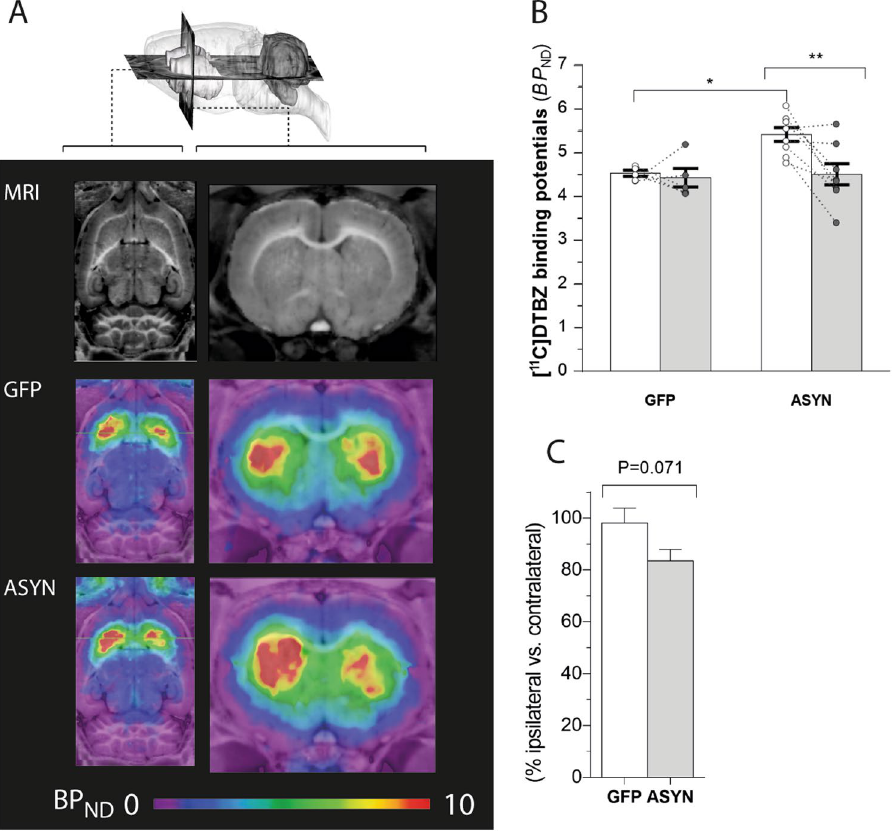
Figure 2. In vivo VMAT2 expression determined by [ 11 C]DTBZ PET. Representative axial ( A , left) and coronal ( A , right) sections of MRI atlas (top row) and parametric maps of in vivo [ 11 C]DTBZ binding potentials ( BP ND ) of GFP (middle row) and ASYN animals (bottom row) at 12 weeks post-surgery. While GFP animals showed similar binding in both sides of the striatum (middle row), a marked decrease in the binding in the ipsilateral side was observed in response to ASYN overexpression (bottom row). Quantification of [ 11 C]DTBZ binding potentials ( BP ND ) in each side of striatum were done using Logan plot with cerebellum as reference input ( B ). DTBZ BP ND was unchanged by GFP overexpression, whereas ASYN overexpression induced a significant reduction as compared to the contralateral side. In addition, we observed a significant difference of the DTBZ BP ND in the contralateral side of the ASYN animals (n = 8) compared to the contralateral side in GFP rats (n = 5). Two-way ANOVA (Interaction: rAAV & side F(1,22) = 3.78 P = 0.06; rAAV effect F(1,22) = 5.49 P = 0.02; side effect F(1,22) = 5.93 P = 0.02); followed by Tukey’s multiple comparisons. * P < 0.05, ** P < 0.01. ( C) Shows the percent-wise difference of ipsilateral side relative to contralateral side in GFP controls and ASYN animals (unpaired t-test, t = 1.98, df = 11, P =